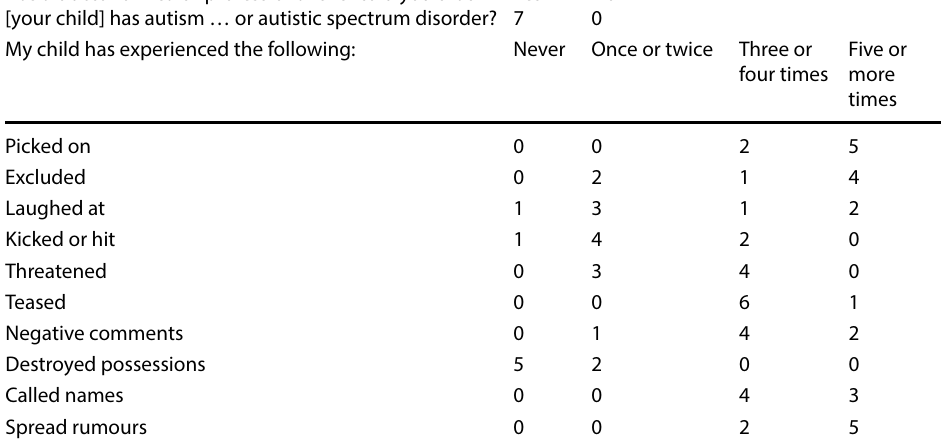
Table 1 Type and occurrence of bullying at school